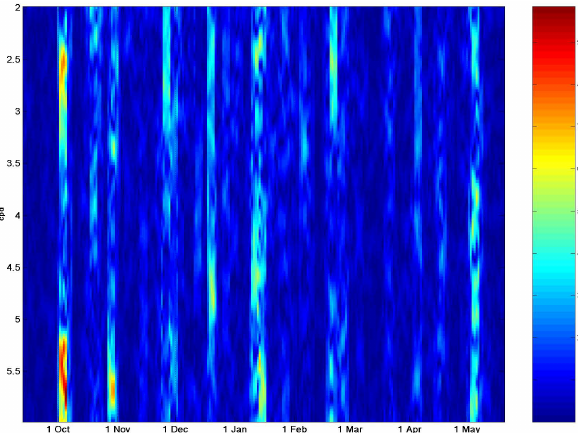
Fig. 15. Time/frequency distribution of vertical currents amplitude at 16m